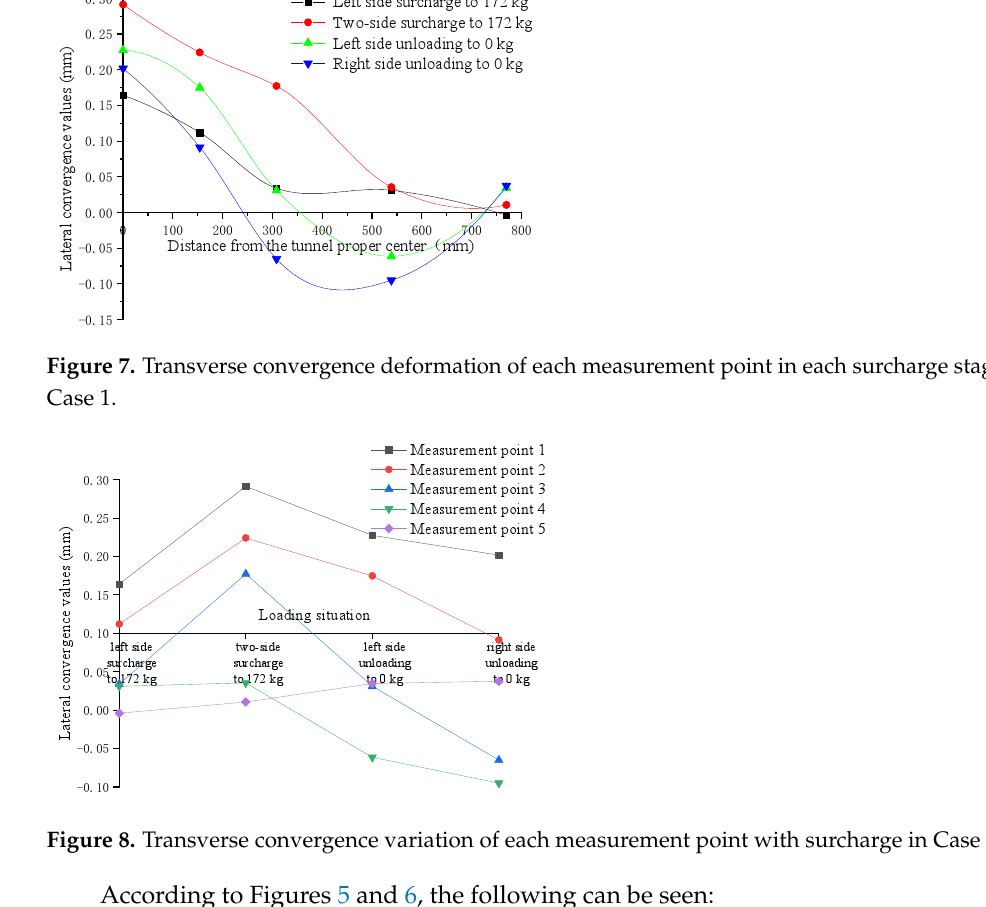
Figure 8. Transverse convergence variation of each measurement point with surcharge in Case 1.